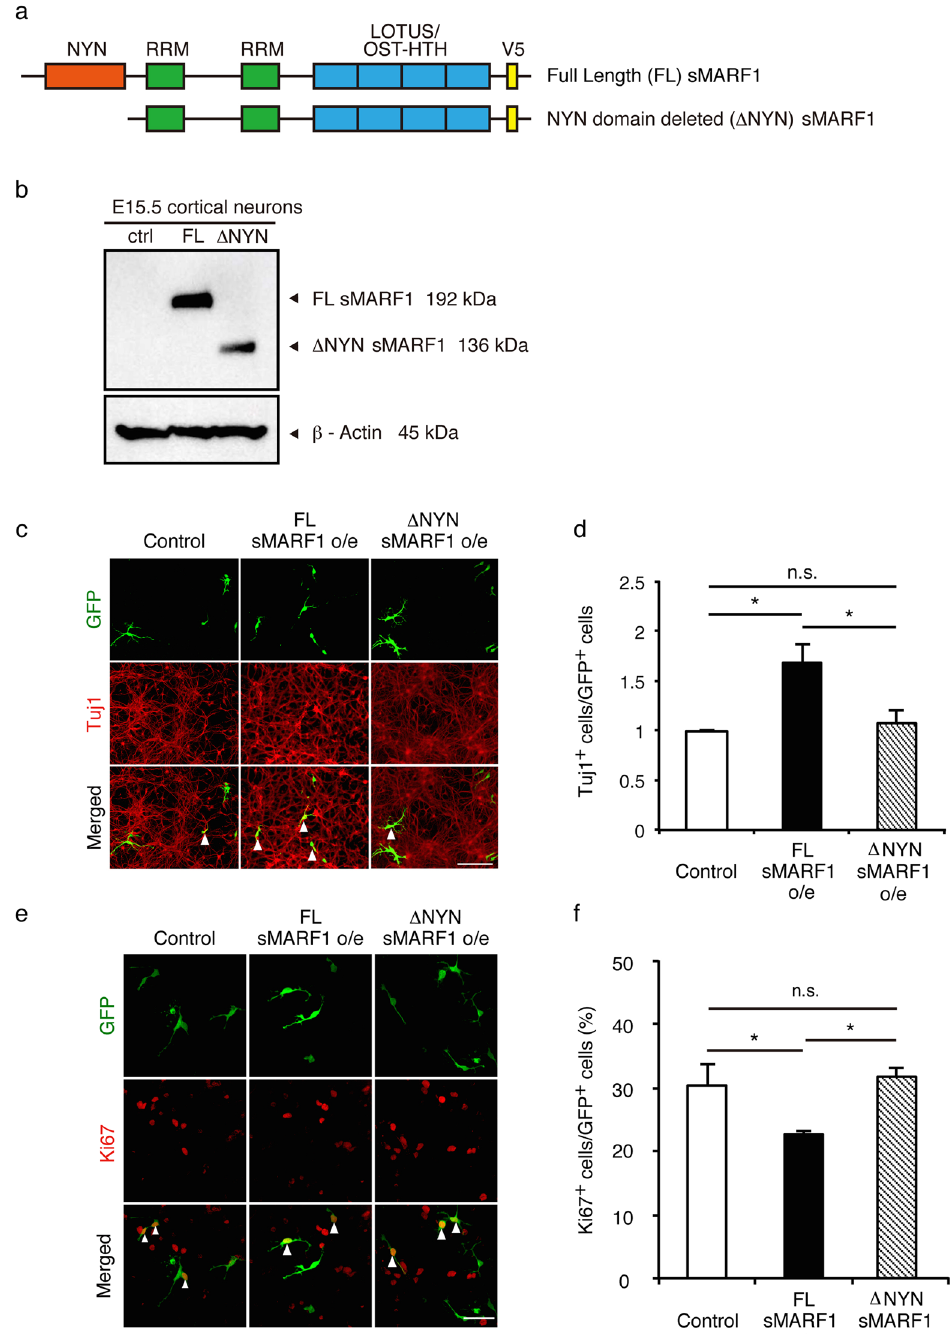
Figure 4. The RNase activity domain of sMARF1 is necessary for neuronal differentiation. ( a ) Domain composition of full-length (FL) sMARF1 and NYN/PIN-like domain deleted ( Δ NYN) sMARF1 with carboxy- terminal V5 epitope tags. RRM; RNA recognition motif, OST-HTH; Oskar-TDRD5/TDRD7-helix-turn-helix 39 . ( b ) Western blotting for V5 epitope in E15.5 cortical neurons transfected with pCAGIG (ctrl), FL sMARF1 expression vector (FL), or Δ NYN sMARF1 expression vector ( Δ NYN). β -Actin was used as a loading control. The full-length membrane is presented in Supplementary Fig. 8c. ( c ) Immunostaining with GFP (green) and Tuj1 (red) in E12.5 cortical progenitors 3 days after transfection with pCAGIG (Control), FL sMARF1 expression vector (FL sMARF1 o/e), or Δ NYN sMARF1 expression vector ( Δ NYN sMARF1 o/e). Scale bar, 100 μ m. ( d ) Quantification of GFP-labeled Tuj1 + cells. * p < 0.05 (n = 4, one-way ANOVA Tukey-Kramer test). ( e ) Immunostaining with GFP (green) and Ki67 (red) in E12.5 cortical progenitors 2 days after transfection with pCAGIG (Control), FL sMARF1 expression vector (FL sMARF1 o/e), or Δ NYN sMARF1 expression vector ( Δ NYN sMARF1 o/e). Scale bar, 100 μ m. ( f ) Quantification of GFP-labeled Ki67 + cells. * p < 0.05 (n = 3, one- way ANOVA, Tukey-Kramer